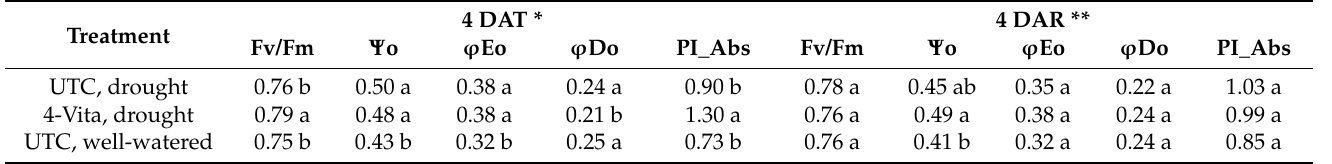
Table 5. Different photosynthetic parameters 4 DAT and 4 DAR. For each trait, at least one letter in common indicates no significant difference.